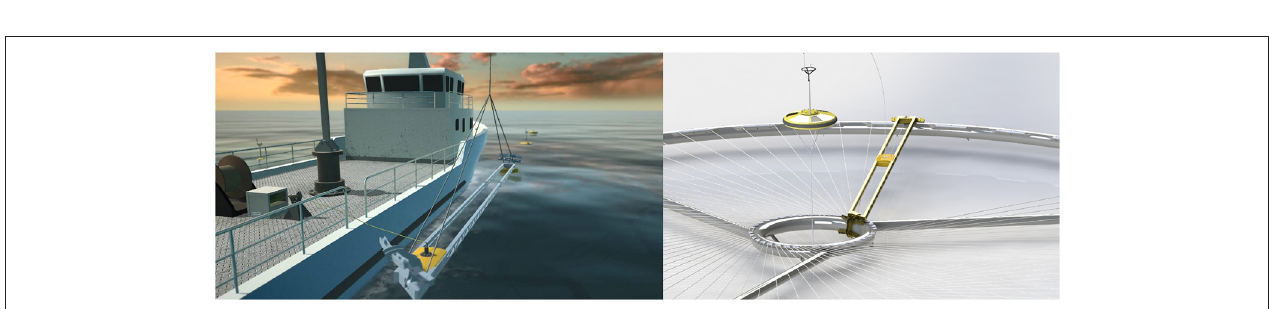
FIGURE 10 | (Left) service vessel deploying the gantry robot, with the rope spinner on deck. (Right) Monitoring buoy fitted onto a SPOKe unit.